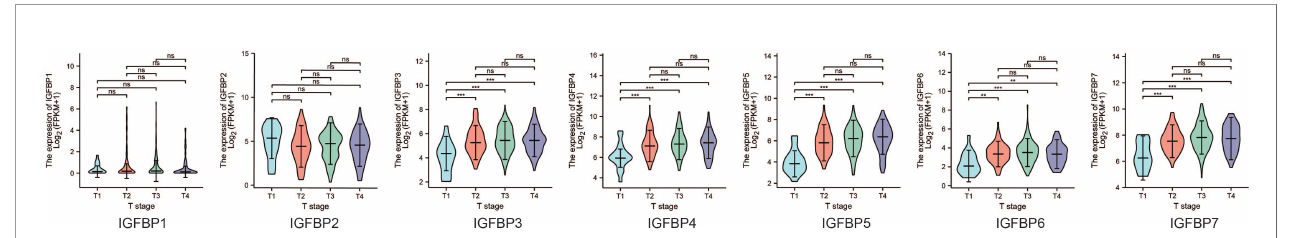
FIGURE 3 | Difference between IGPBP1 – 7 expression and tumor stage in STAD patients from the TCGA database.